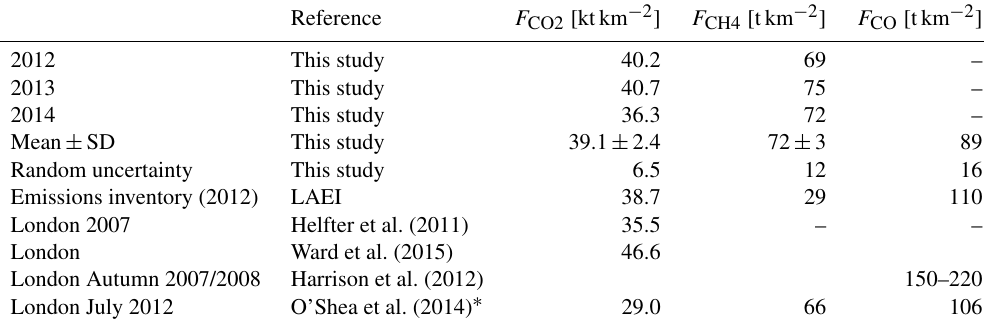
Table 1. Annual totals of carbon dioxide flux and methane flux calculated from monthly averages for the period 2012–2014. The data period September 2012–March 2013 (no ultrasonic anemometer) was gapfilled using available monthly averages obtained over the remaining measurement period. Due to insufficient temporal coverage, individual annual budgets for 2012-2014 could not be derived for the carbon monoxide flux. A composite annual emissions estimate was compiled instead which makes use of all available monthly averages of F CO over the study period September 2011 to December 2014. Data from the London Atmospheric Emissions Inventory (LAEI; emissions for the central London boroughs of Westminster and Camden) and previous measurement campaigns are provided for comparison with the current